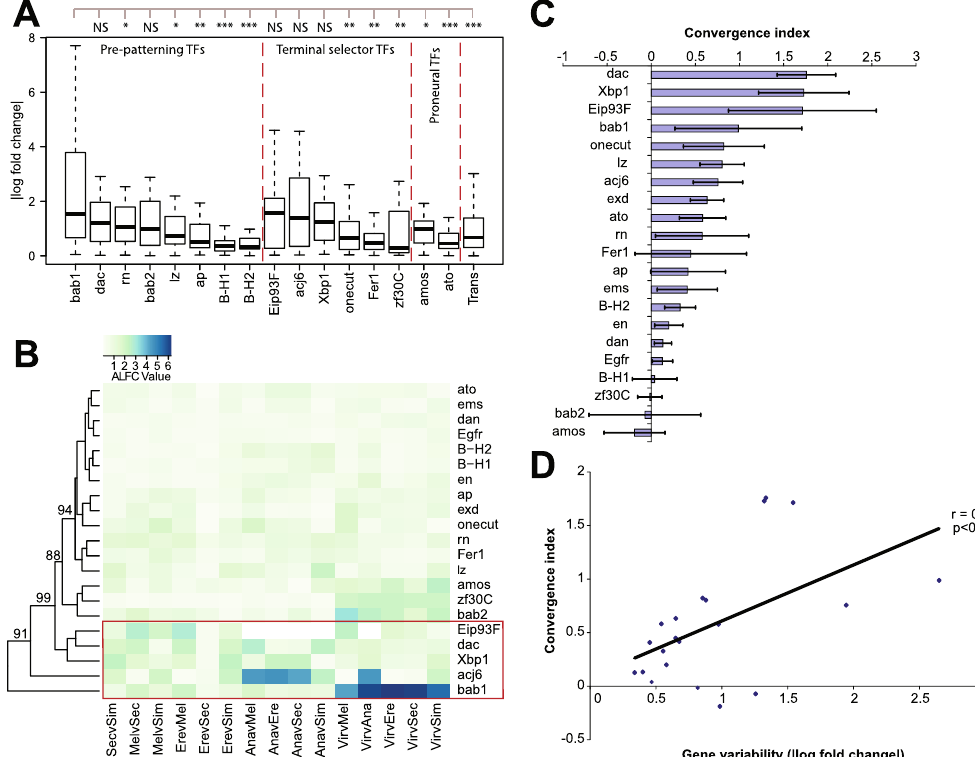
Figure 5. Transcriptional variability of antennal developmental transcription factors across six Drosophila species. (A) Boxplot and ( B ) heatmap plotting the absolute log fold change (ALFC) in the expression of transcription factors known to specify the adult olfactory system 15–17,20 across all pairwise interspecies comparisons and across all three developmental time points (T1–T3). The boxplot shows combined values for each transcription factor across development, and includes values for the entire antennal transcriptome (Trans) for comparison. Statistical comparisons show results for ANOVA + Tukey’s HSD ( * p < 0.05, ** p < 0.01, *** p < 0.001, NS = not significant). The post-hoc test compares bab1 AFLC to the other TF. A non-parametric Kruskal-Wallis H test for the boxplot also had p-value < 0.001 (df = 5). In the heatmap, ALFC values shown are the mean ALFC value across development; invalid comparisons (NAs) are white/blank, highly variable genes are highlighted in red, and numbers indicate bootstrap support for the clustering analysis. (C) Convergence index values (see Methods) showing levels of convergence between D . sec . and D . ere . for antennal developmental transcription factors, averaged across development (T1–T3). Positive values indicate convergence while negative values indicate divergence. Error bars indicate S.E.M. (D) Plot of convergence index values versus absolute log fold change (ALFC) values for antennal developmental transcription factors. ALFC values shown are the mean ALFC value across all interspecies pairwise comparisons. The solid line shows a fitted line, with r as Pearson’s correlation